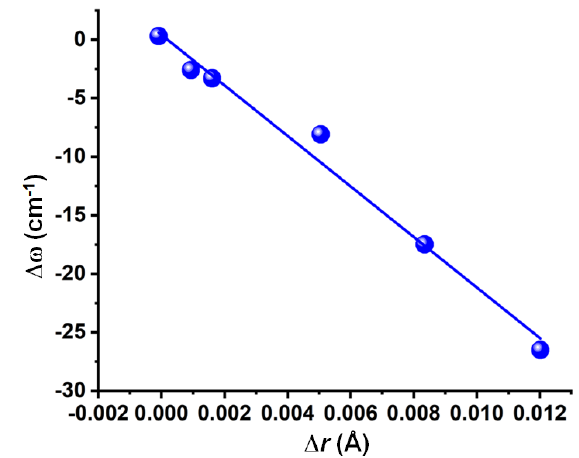
Figure 4. Dependence of the MP2/aug-cc-pVTZ level shift in the harmonic vibrational stretching frequency of the chalcogen donor bond ( ∆ ω ) on the change in the chalcogen donor bond distance ( ∆ r ) for the six O-bonded complexes of Figure 3. The Adj. R 2 of the linear fit was 0.98. Table 1. Selected physical properties of the six binary complexes (Figure 3), obtained using MP2/aug- cc-pVTZ a,b .